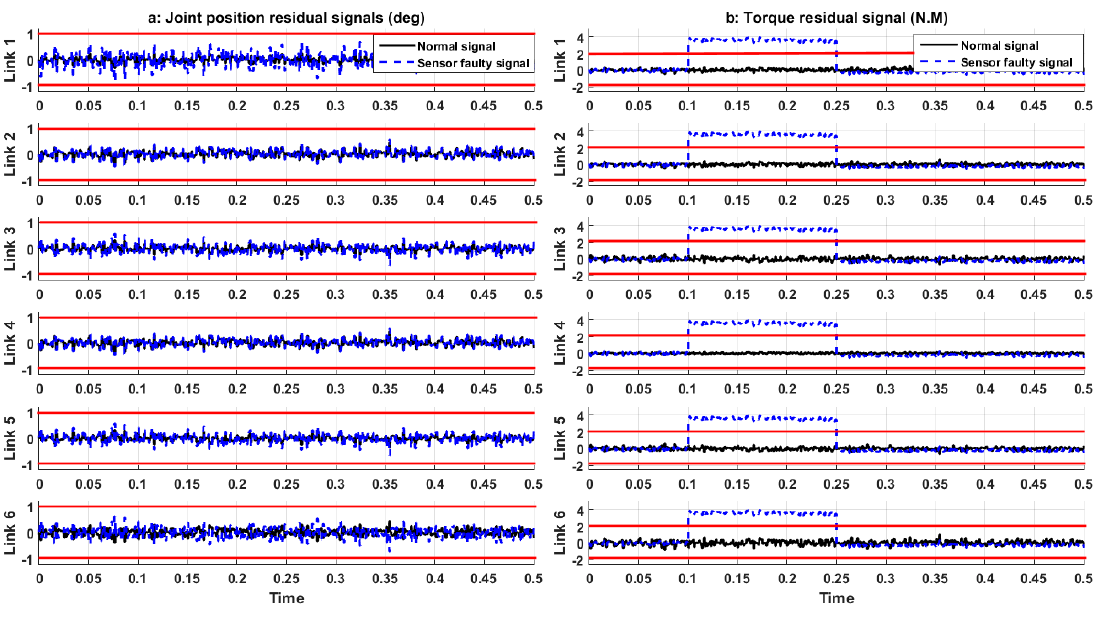
Figure 13. Residual signals in the sensor faulty condition: ( a ) Joint variable residual signals and ( b ) torque residual signals.